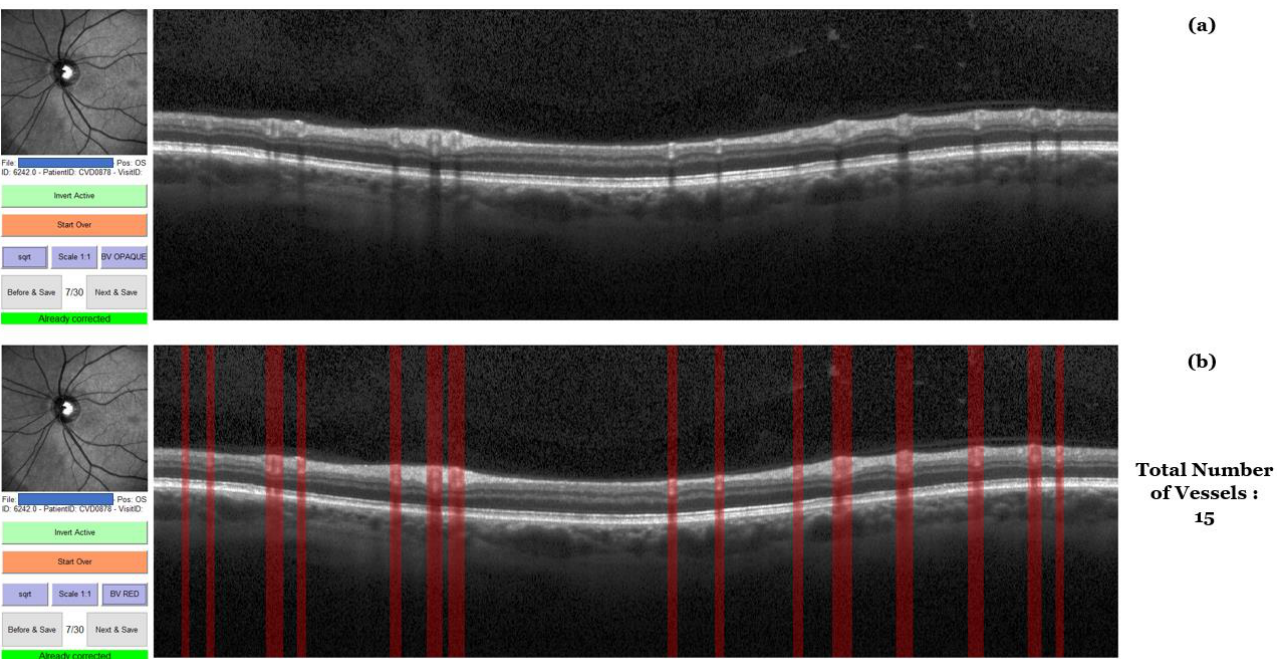
Figure 1. Layout of the OCT image in the OCTSEG software. The blue circle on the right-hand image is unwrapped and showcased on the left side. The blue line shown in the left side of the picture is indicating the vessel that is highlighted with red square.